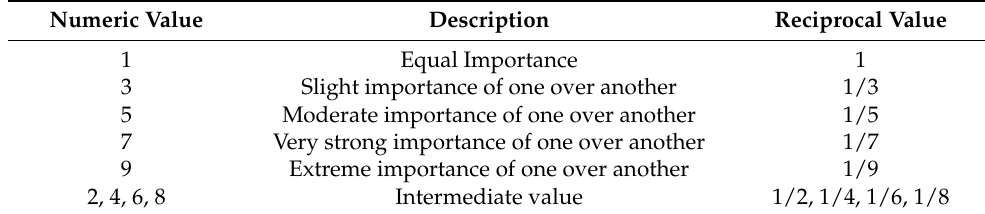
Table 2. Saaty (1980) linguistic and numeric scale for AHP. Numeric Value Description